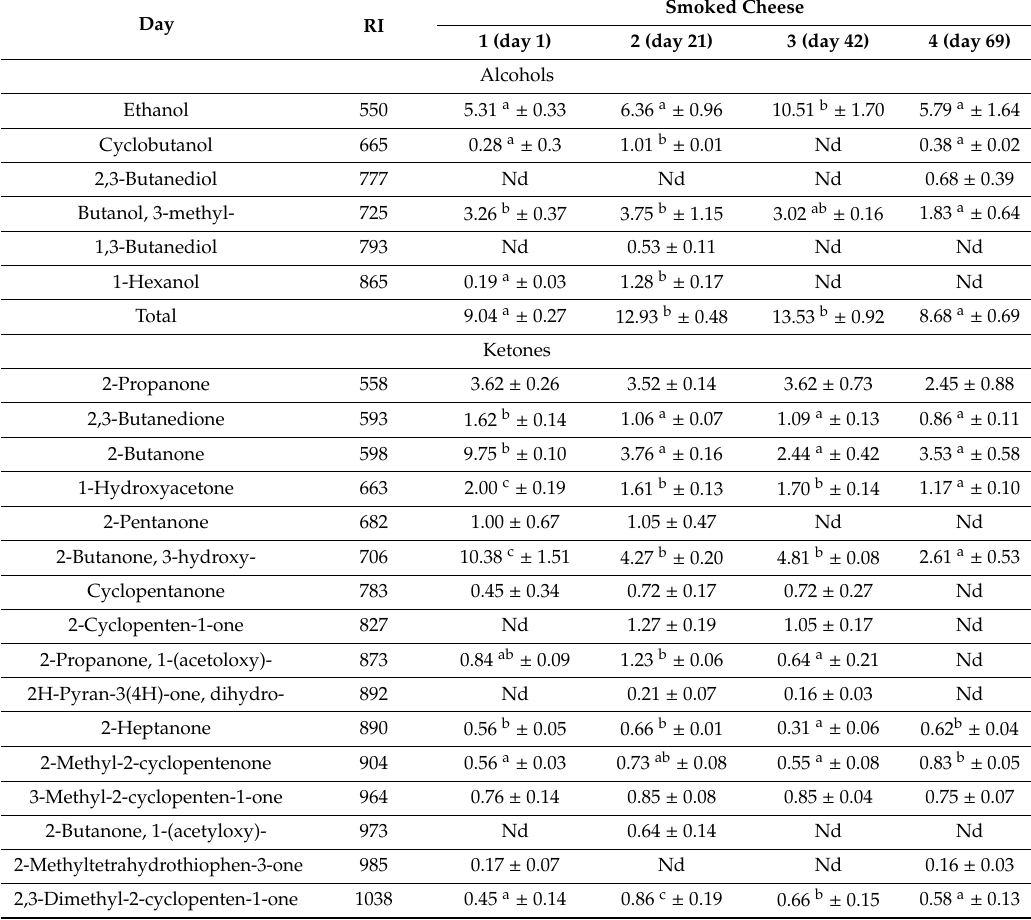
Table 3. Area percentage of the volatile compounds detected in cheeses during 69-day storage (mean ± SD, n =